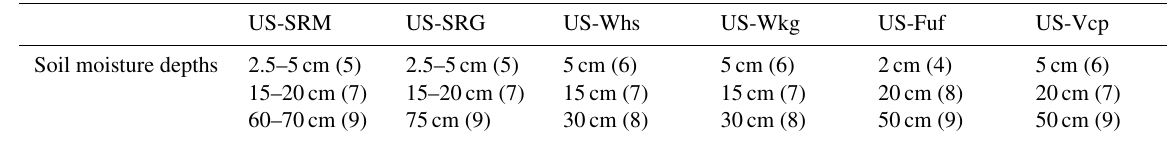
Table 3. Soil moisture measurement depths (and corresponding model layer in brackets – see Table